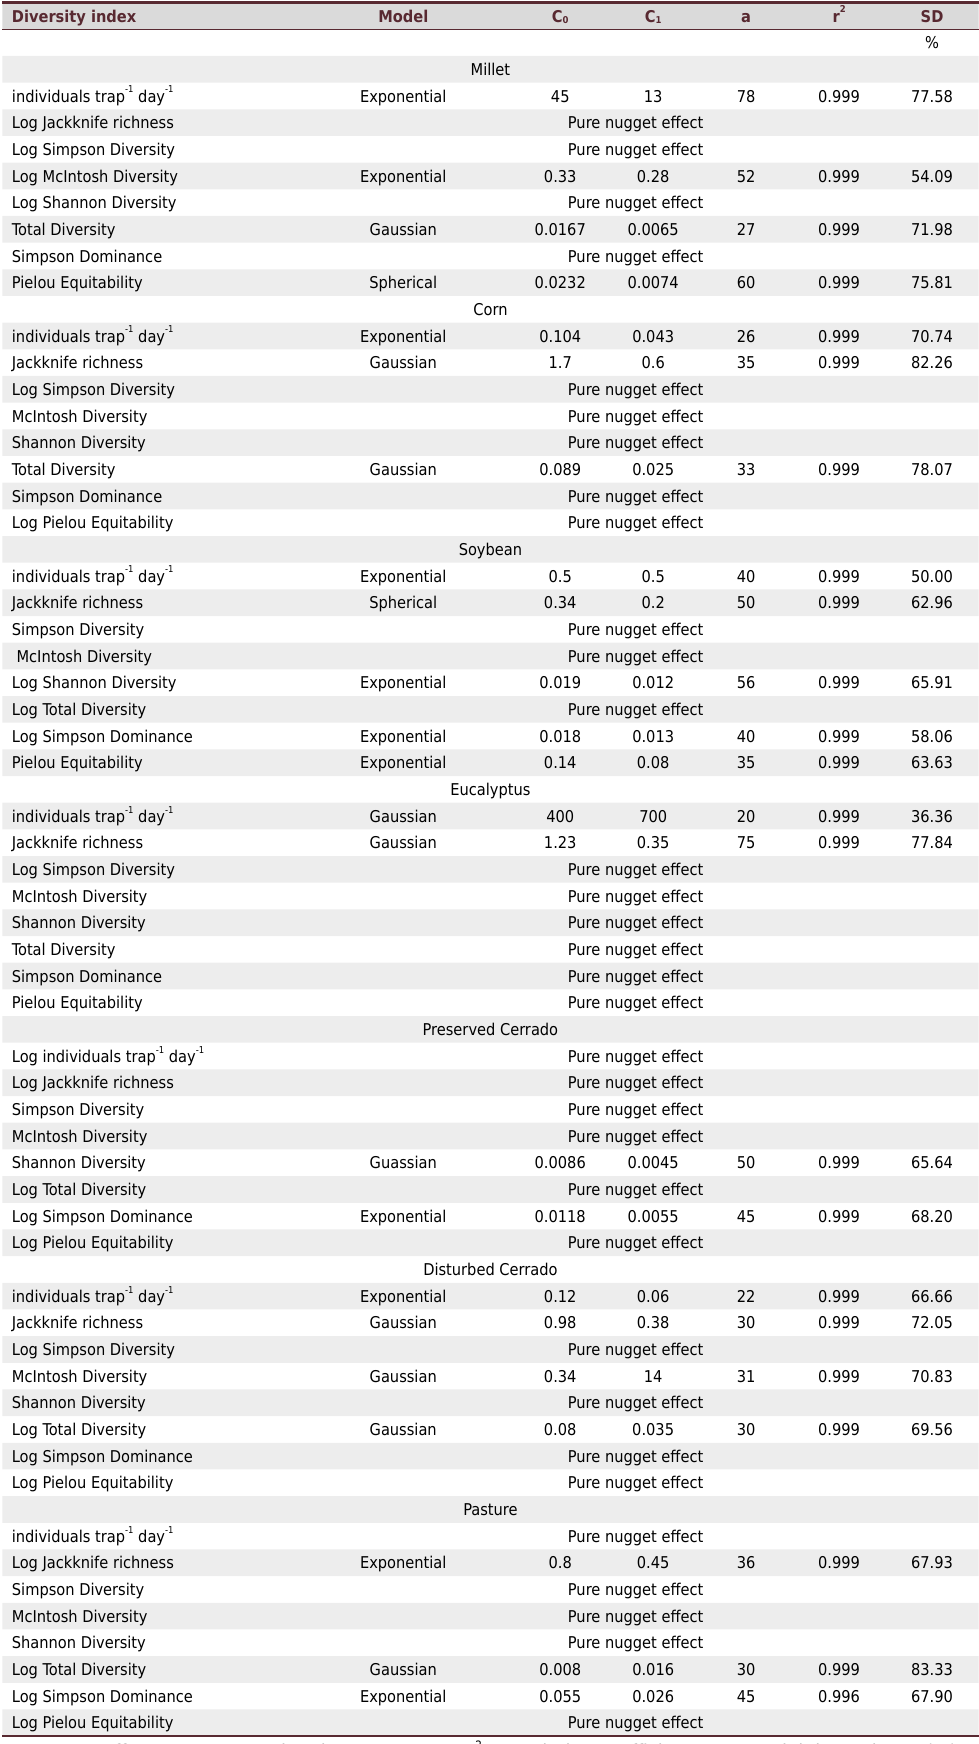
Table 6. Semivariogram fitting parameters for biodiversity indices in the studied areas Diversity index